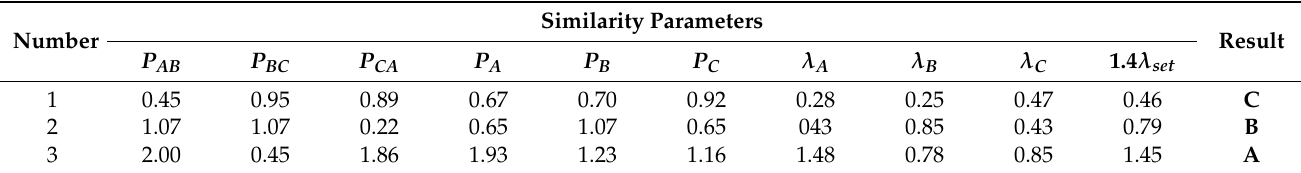
Table 4. Similarity parameters and faulty phase selection results in a real power distribution